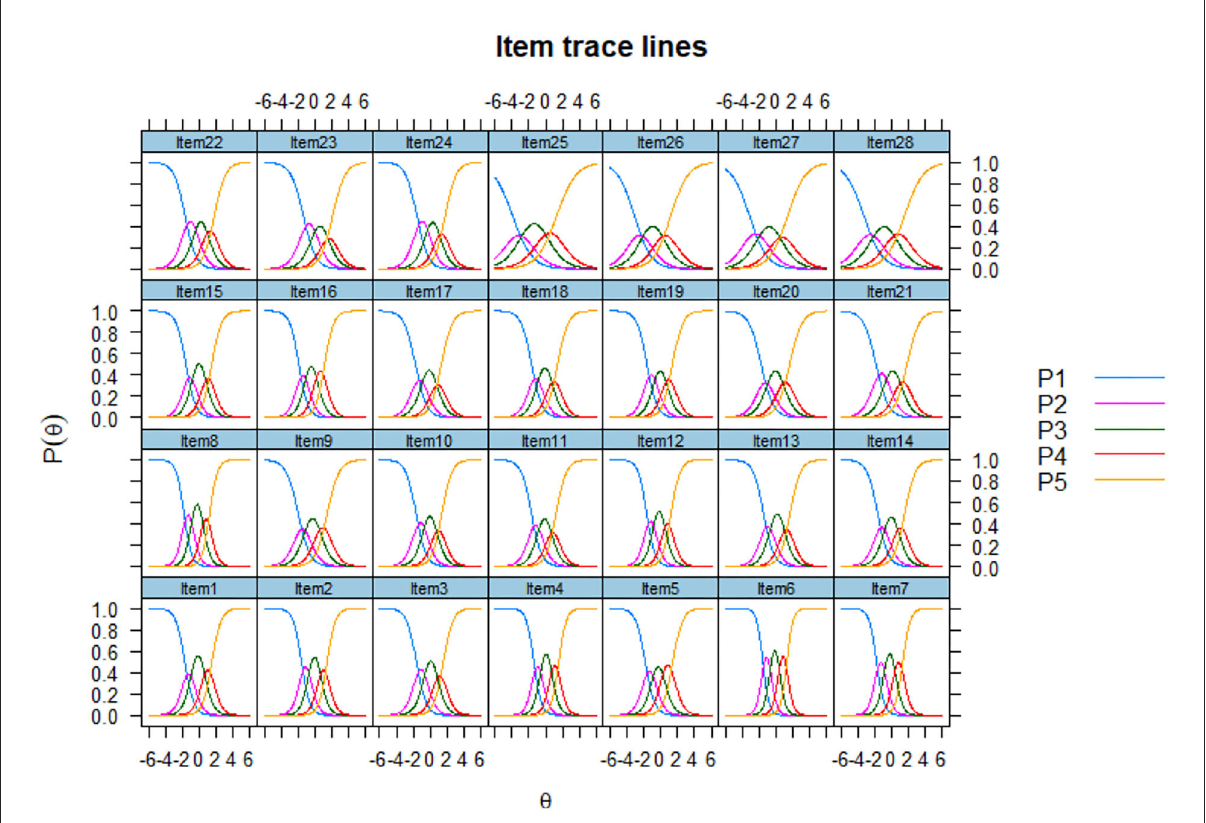
FIGURE1 Item response